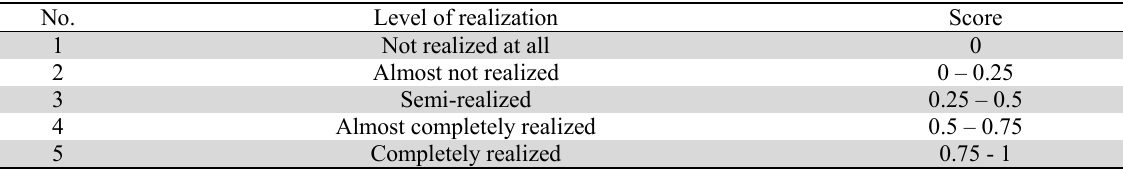
Guide to determination of factors’ realization